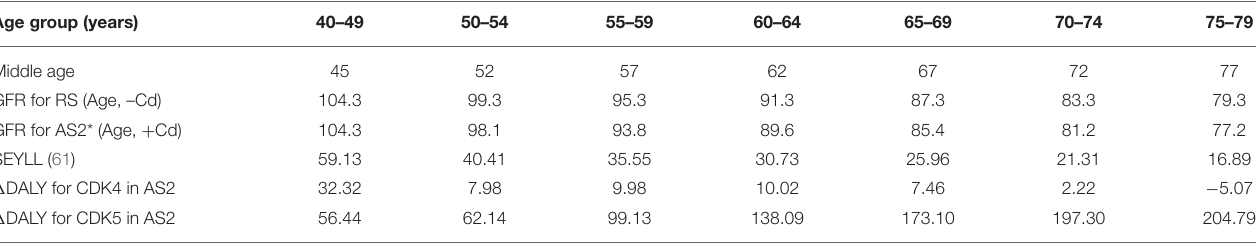
TABLE 5 | Estimated cadmium–related GFR and net health impact ( 1 DALY) associated with CDK4 * and CDK5 ** through the consumption of rice in alternative scenario 2 in different age groups. Age group (years)